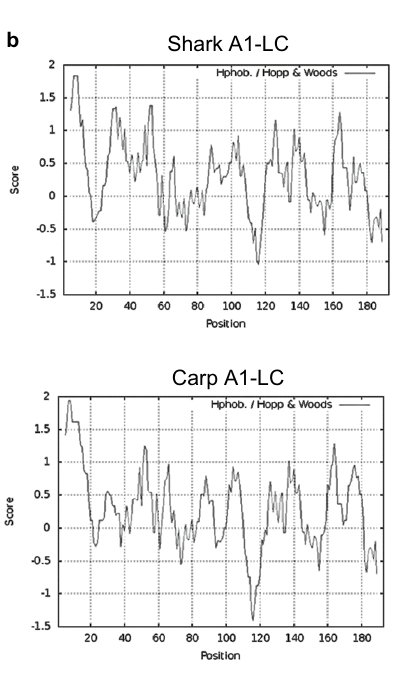
Figure 3. Hydrophicility analysis of the A1 and A2-LCs of banded houndshark Triakis scyllium . ( a ) comparison of the amino acid sequences of myosin A1- and A2-light chains. The numbers on the right side represent the amino acid sequence from the N-terminus. Gaps were inserted to optimize the sequence alignment. Dots indicate identical amino acid residues between them. ( b ) hydrophilicity values of the shark (upper) and carp (lower) myosin A1 light